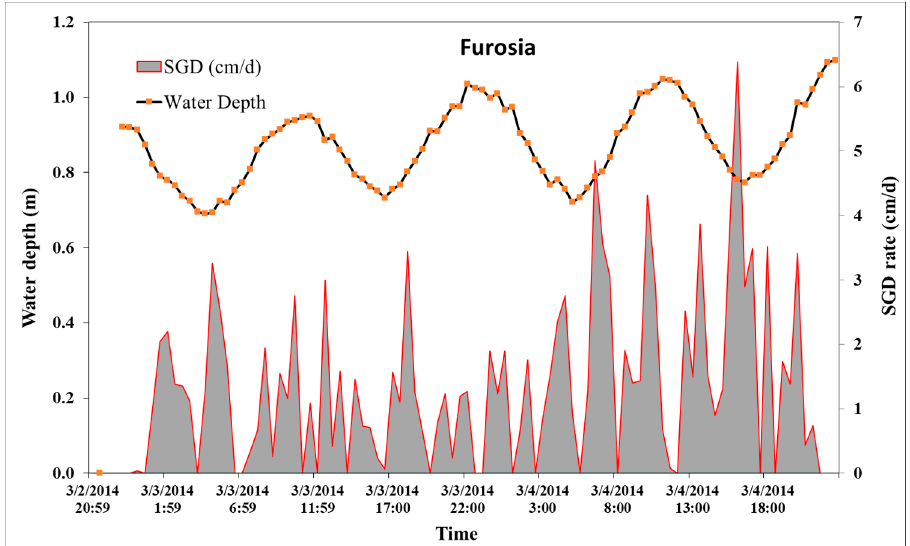
Figure 6. Relationship between ebb/flood tide and the SGD rates.